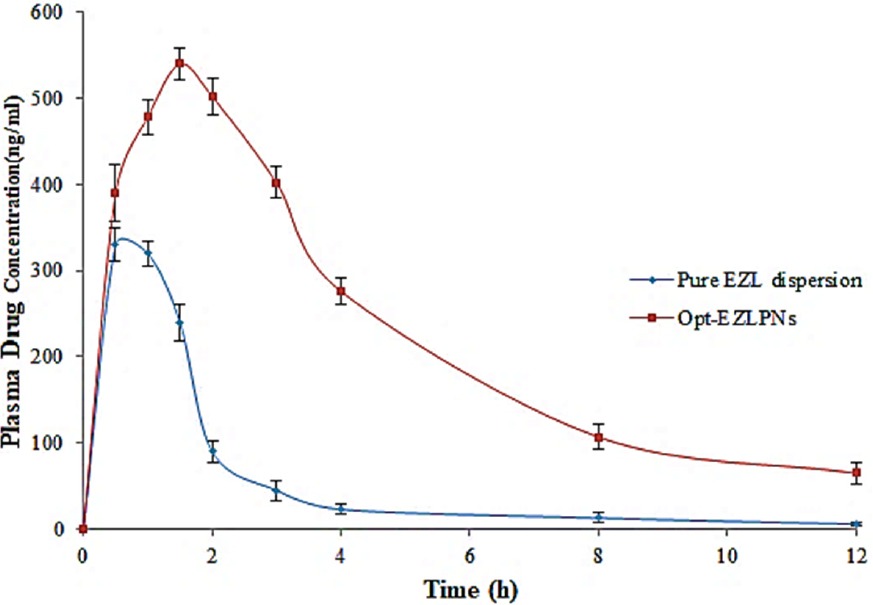
Figure 11. EZL plasma concentration vesicle size time profile of pure EZL and EZL ‐ PNsopt. Table 4. Pharmacokinetic parameters of pure EZL dispersion and EZL-PNopt. The parameters evaluated on six animals and shown as mean ±